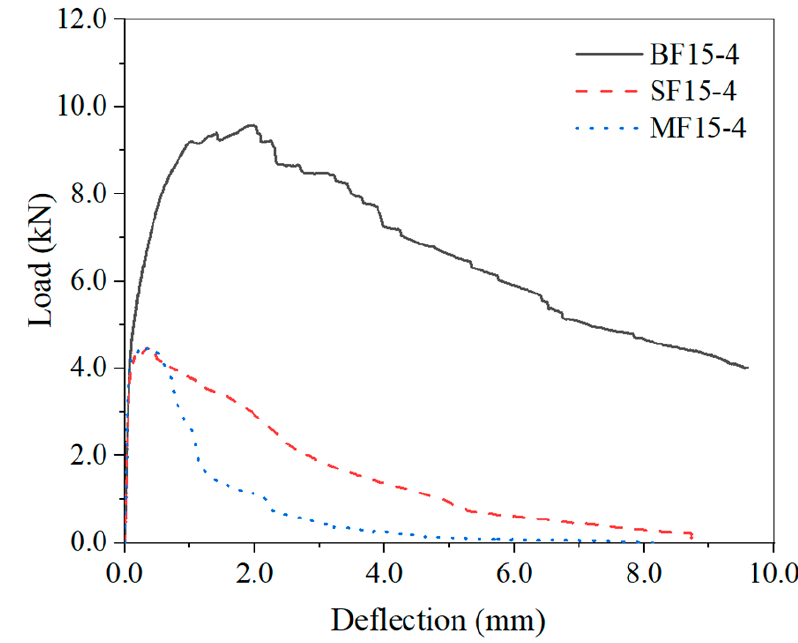
Figure 10. Typical load-deflection curves of SFHSC beam reinforced.